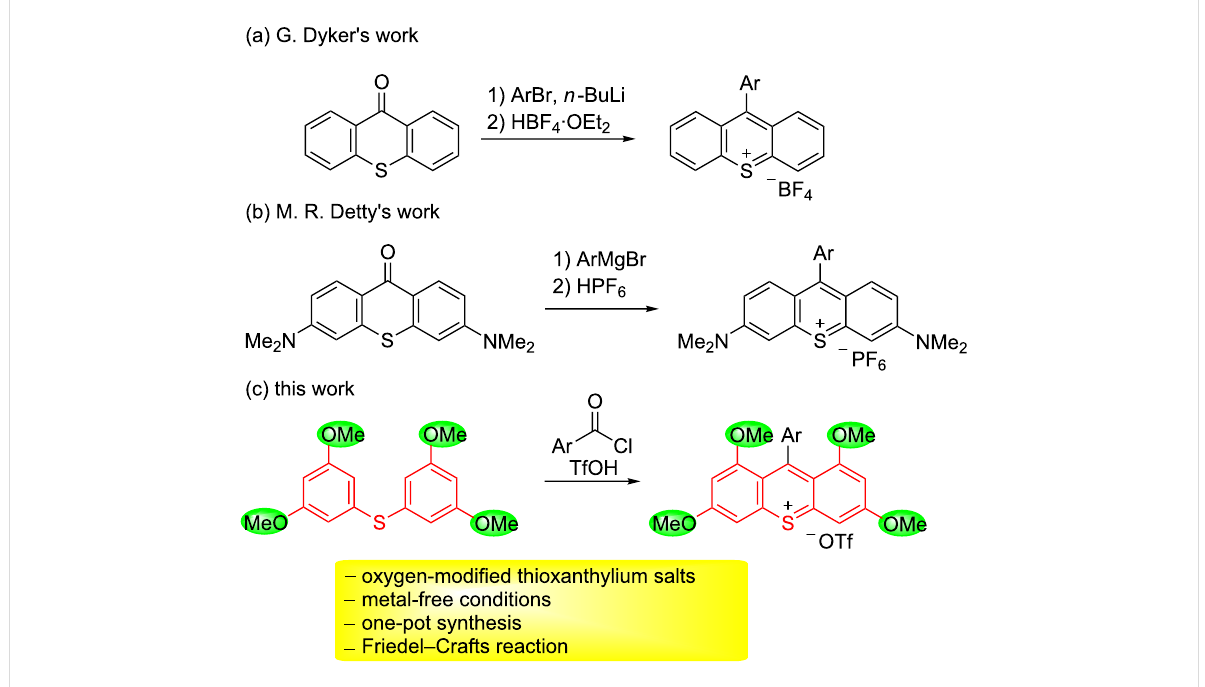
Scheme 1: The representative synthesis of thioxanthylium salts.